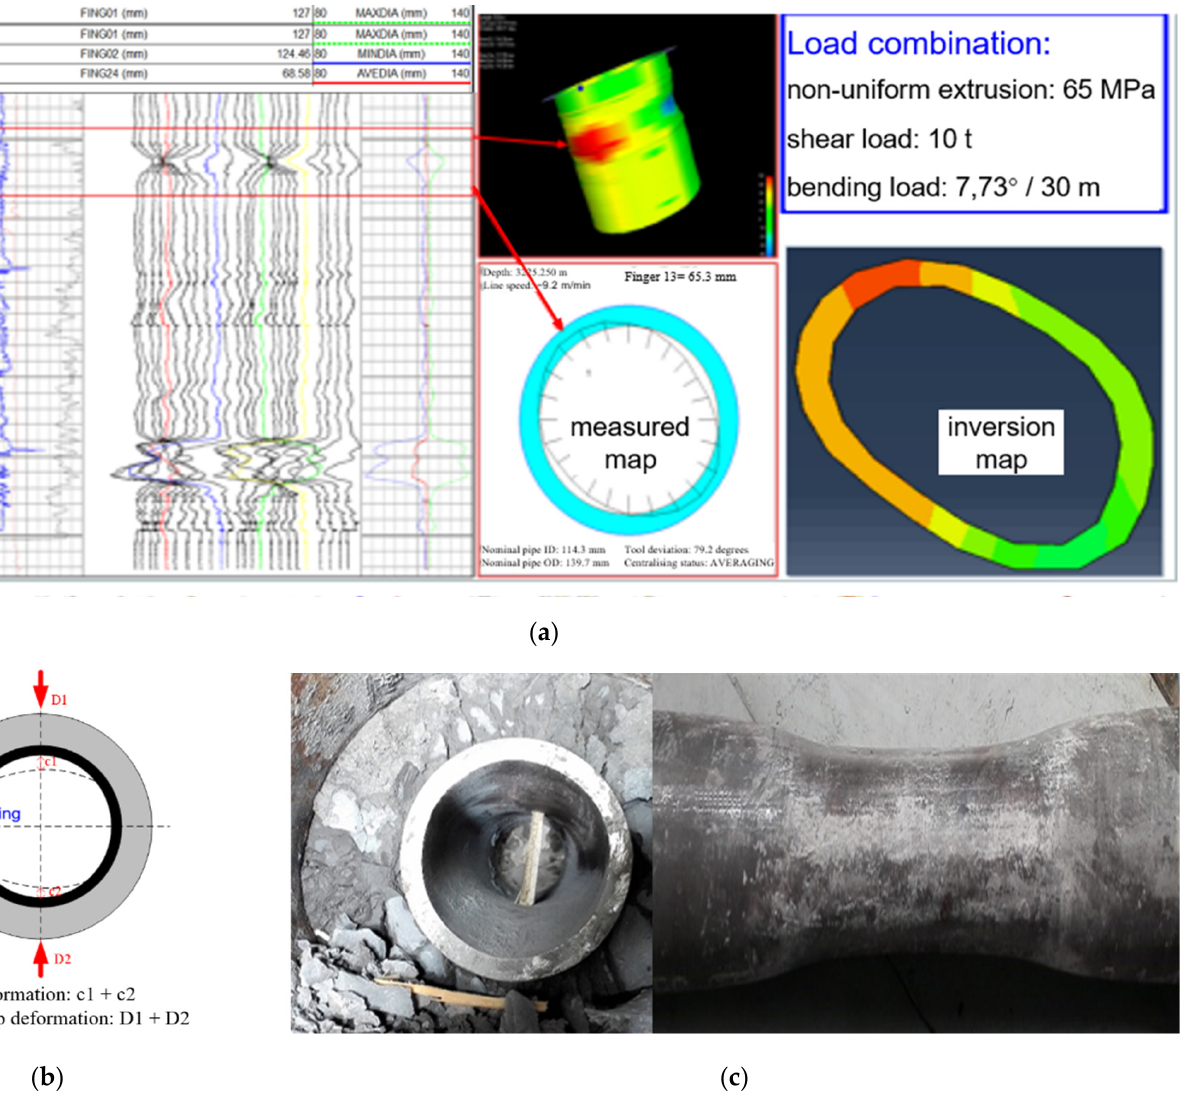
Figure 2. Deformation well data analysis: ( a ) logging curve and simulation inversion; ( b ) casing deformation and formation slip; ( c ) test verification.